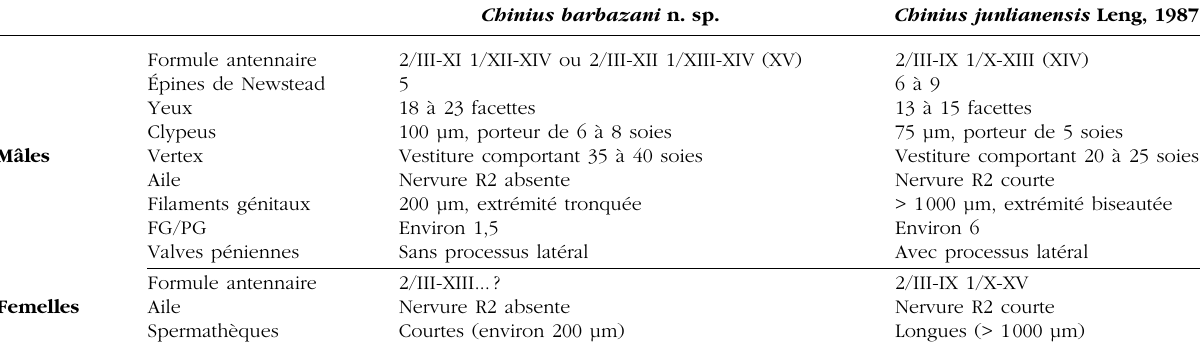
Tableau I. – Principaux caractères différentiels entre Chinius barbazani n. sp et C. junlianensis